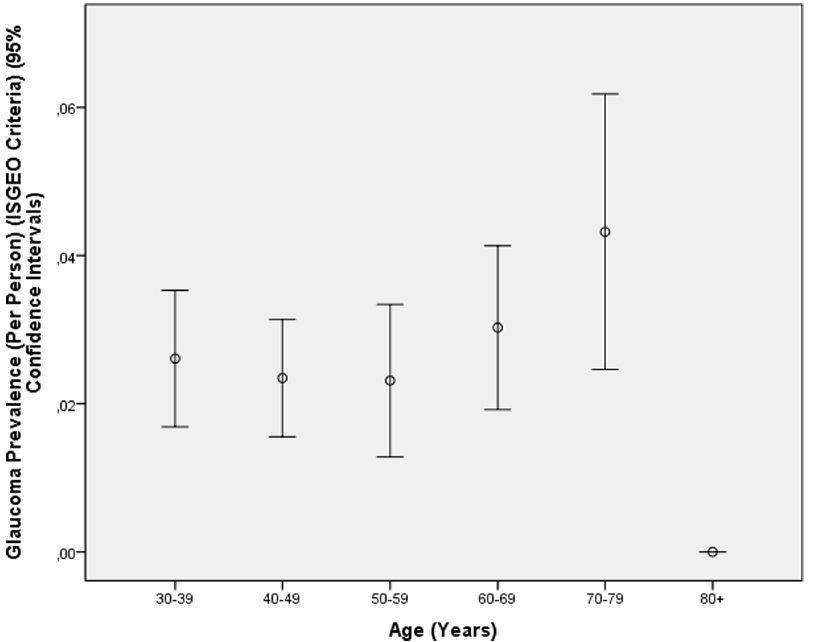
Figure 2. Prevalence of Glaucoma (As Defined by the Criteria of the International Society of Geographical and Epidemiological Ophthalmology ISGEO) in the Central India Eye and Medical Study. doi:10.1371/journal.pone.0076434.g002 PLOS ONE |